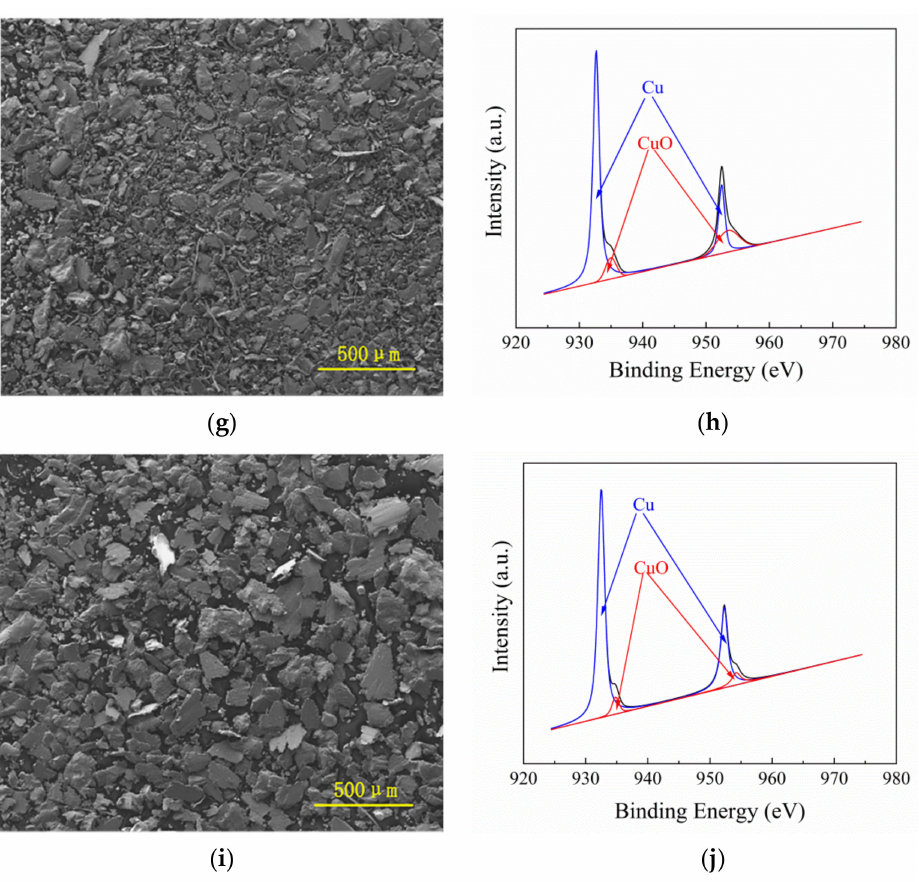
Figure 7. SEM images of the worn-out debris produced under different loads and the corresponding XPS high-resolution spectra of copper: ( a , b ) 15 N; ( c , d ) 25 N; ( e , f ) 35 N; ( g , h ) 45 N; ( i , j ) 55